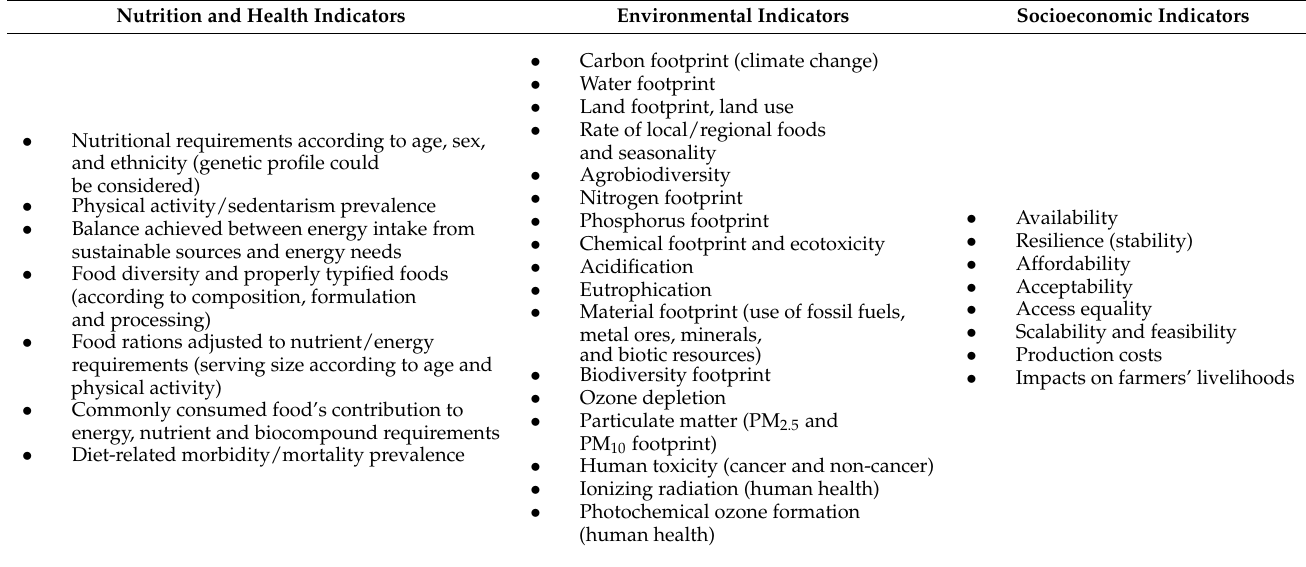
Table 5. Proposed indicators for assessing sustainable healthy